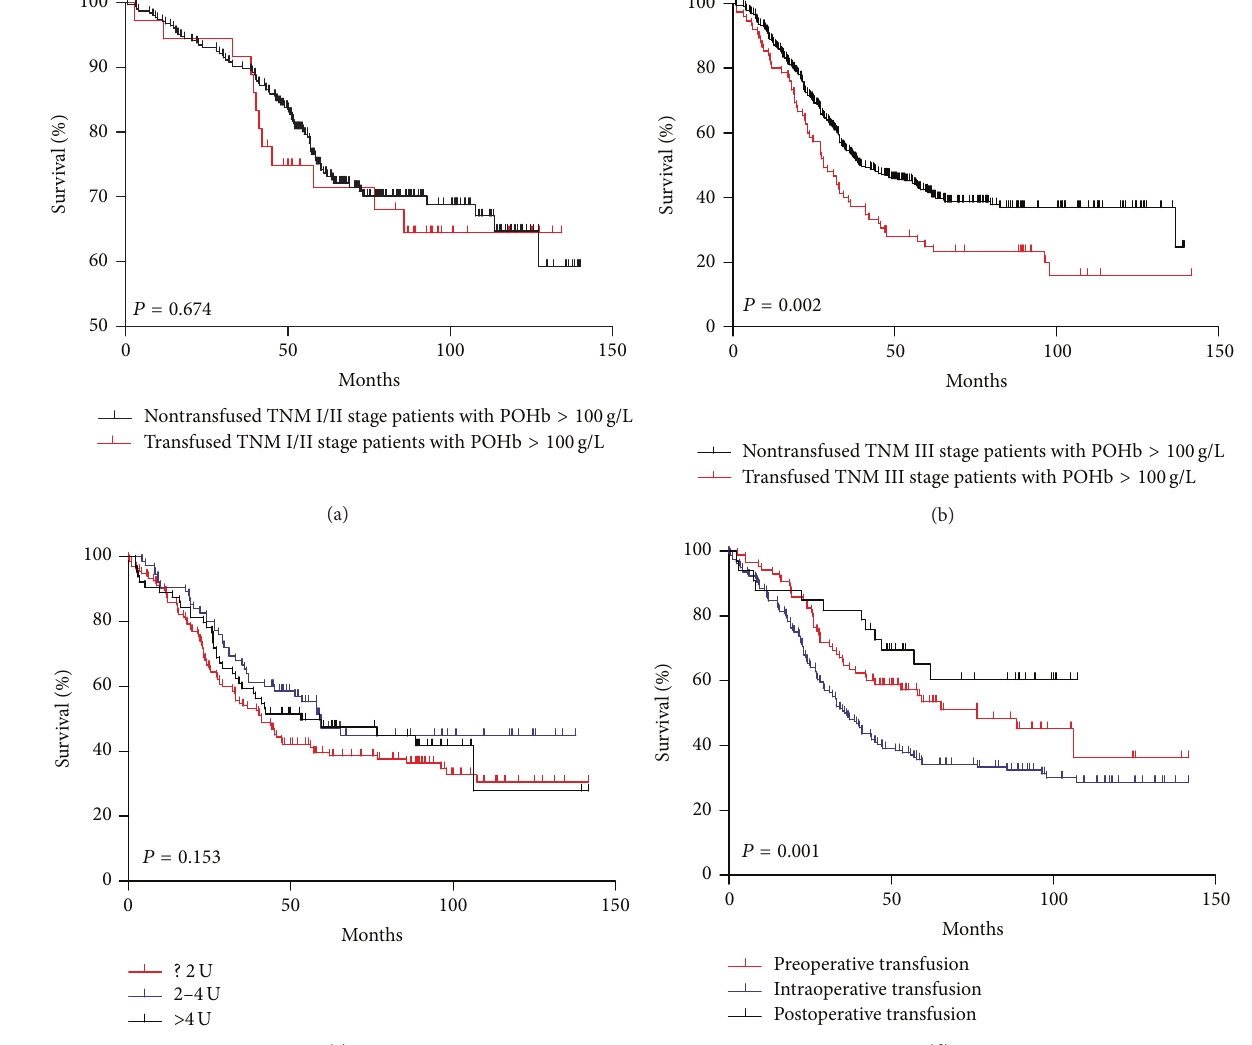
Figure 2: (a) Survival analysis of transfused and nontransfused TNM I/II stage patients with POHb > 100g/L. (b) Survival analysis of transfused and nontransfused TNM III stage patients with POHb > 100g/L. (c) Survival analysis of transfused patients with different units of blood. (d) Survival analysis of transfused patients with different transfusion